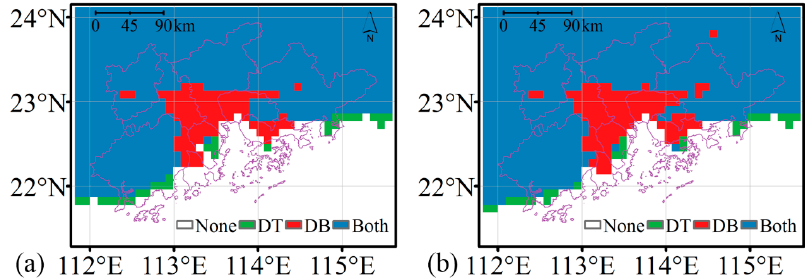
Figure 7. Comparison of the spatial coverage of multiyear mean AOD derived from ( a ) Terra and ( b ) Aqua DT and DB 10 km AOD products for 2006–2015. Pixels included only in the DT or DB 10 km AOD data are marked in green and red, respectively. Pixels covered by both data sets are marked in blue.